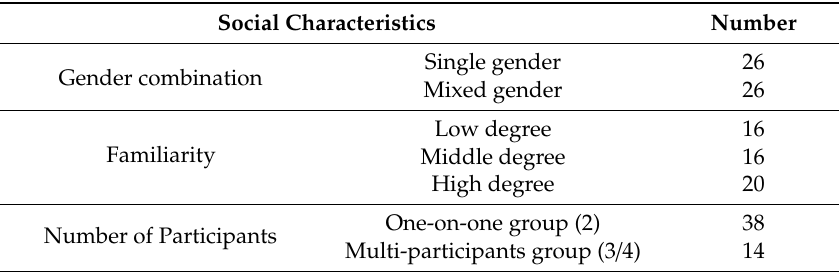
Table 1. Social Characteristics of Participants.